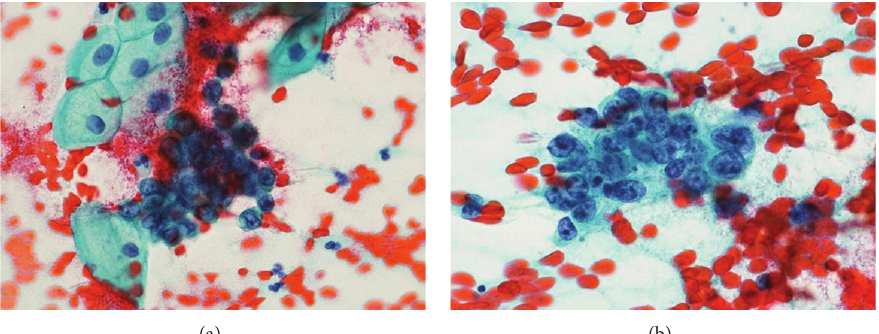
Figure 1: Cytologic features of LCNEC. (a) Pap smear of the vagina shows atypical oval cells with scant cytoplasm and hyperchromatic coarse nuclei. Surface squamous cells showed enlarged nuclei with fine granular chromatin. (b) Pap smear of the uterine cervical tumor shows tumor cells in overlapping clusters containing oval nuclei with coarsely clumped chromatin, irregular-shaped nucleoli, and moderate granular cytoplasm.